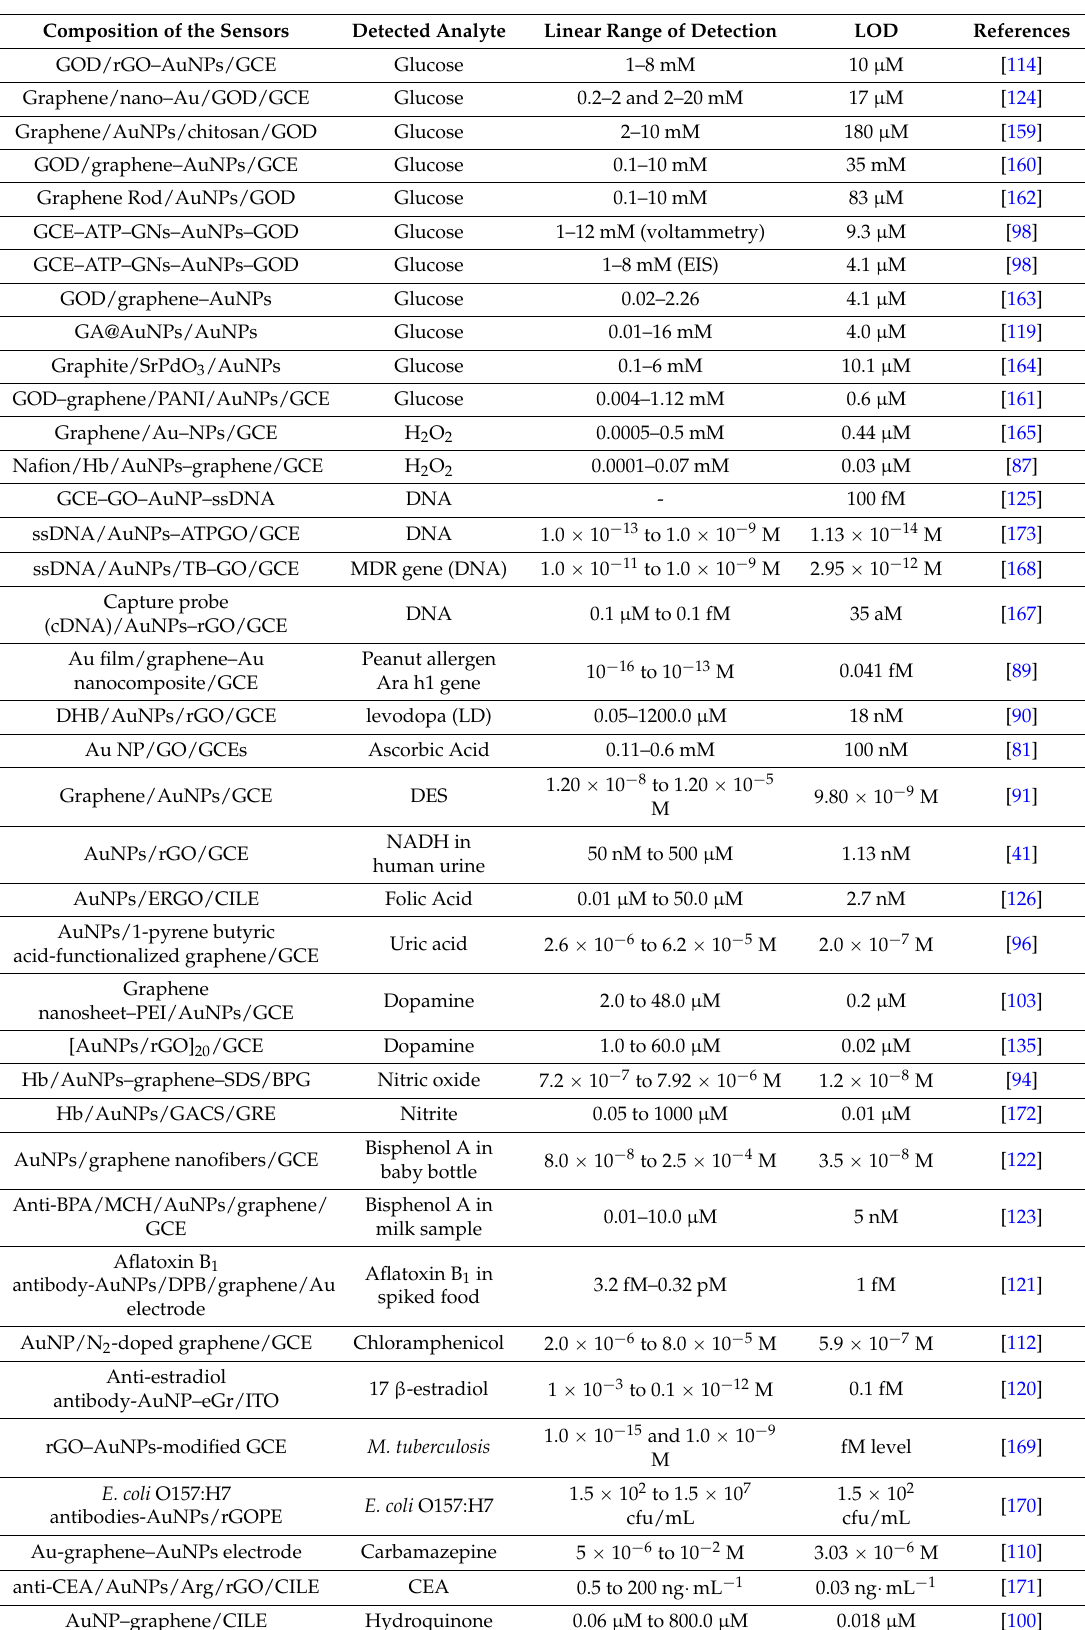
Table 6. Graphene–gold nanocomposites-based electrochemical biosensors, target analytes with respective specificity of